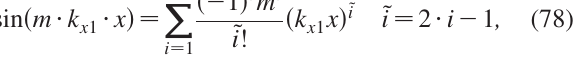
FIG. 11. Spectral power of the transverse field integral distri- bution of a standard UE112 L -shim quadrupole for expansion ranges between 100 and 800 mm (number of Fourier coefficients between 30 and 240). The plot shows the robustness of the expansion procedure with respect to the range of expansion. The high frequency cutoff is defined by the ratio of the number of coefficients and the expansion range. The accuracy at high frequencies improves with a bigger expansion range.